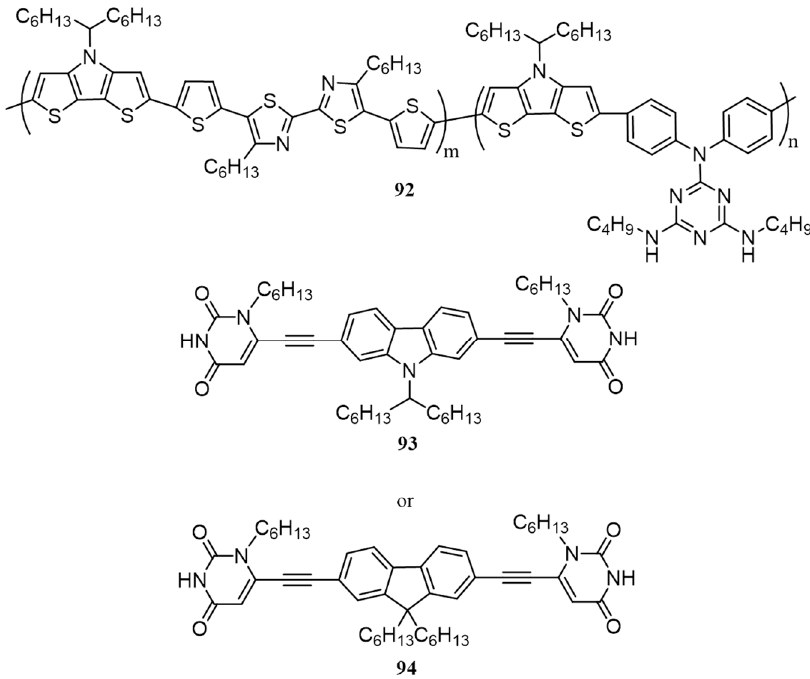
Figure 31. Chemical structure of the conjugated main-chain polymer ( 92 ) and